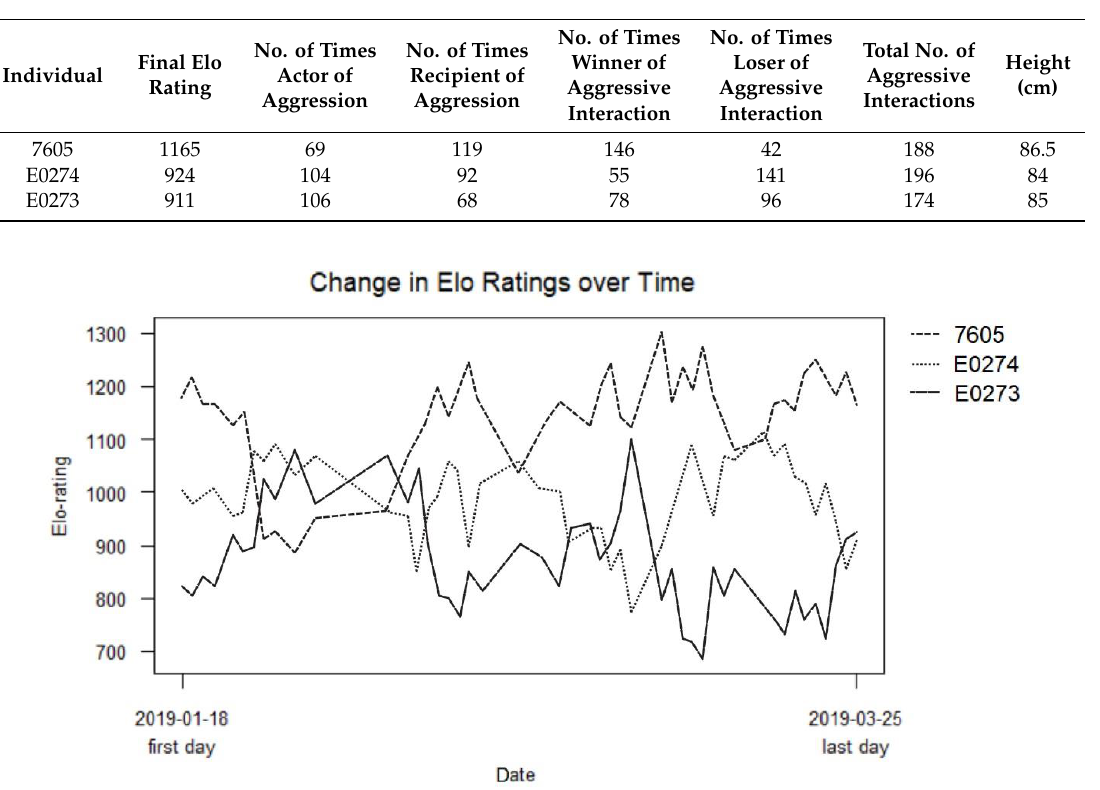
Table 2. The final Elo rating scores, number of times actor and recipient of aggression, number of times winner and loser of aggression, total number of aggression interactions and height of the three Galápagos tortoises. The higher the Elo rating, the more dominant the individual.